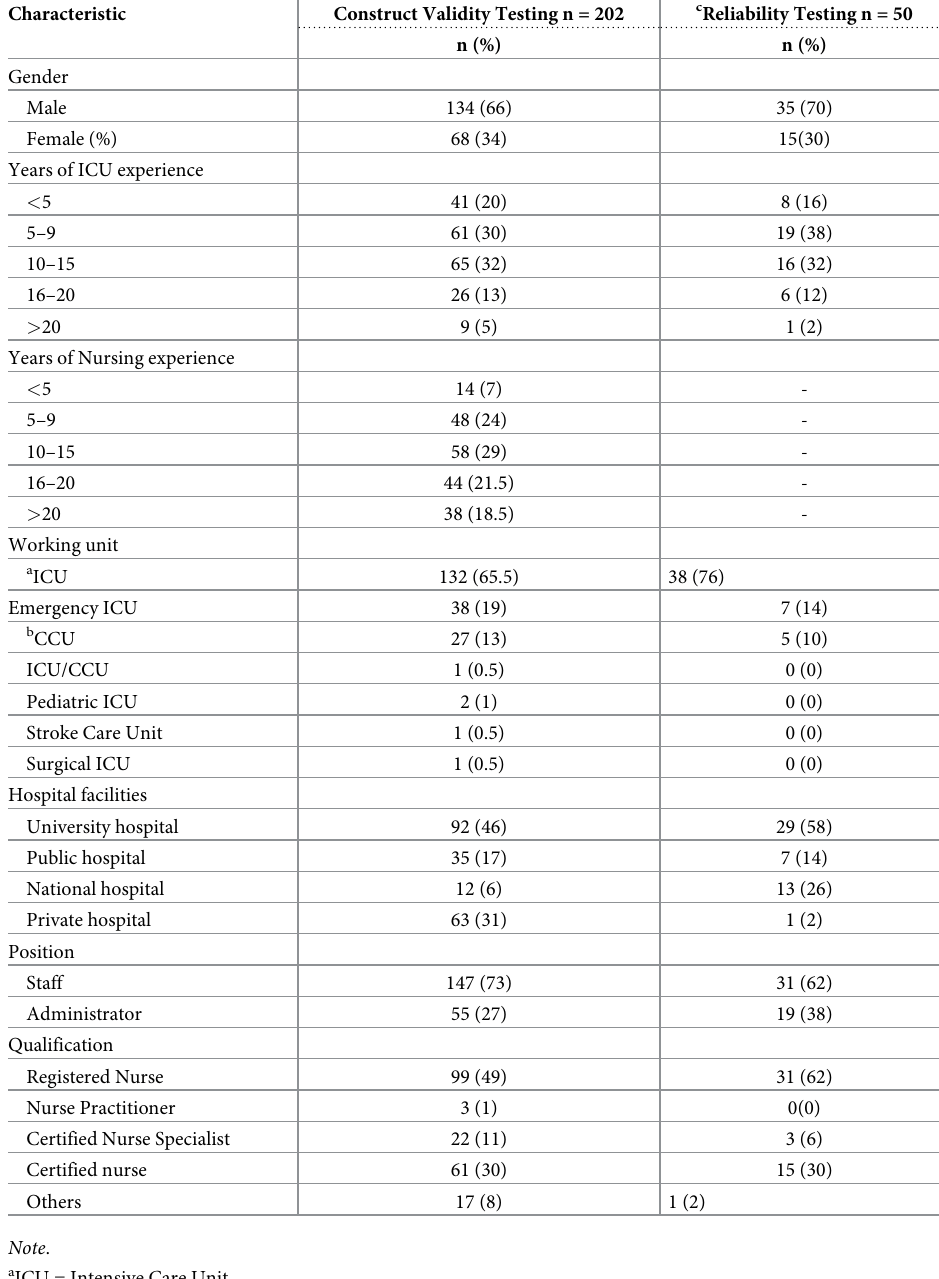
Table 1. Participant characteristics for construct validity and reliability